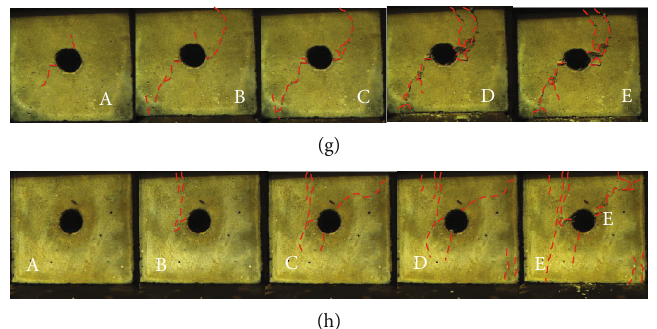
Figure 9: Comparison of crack growth of specimens when the lateral pressure is 0MPa. (a) Details of SN0-1 stress-strain curve. (b) Details of SN0-2 stress-strain curve. (c) Details of SN0-3 stress-strain curve. (d) Details of SN0-4 stress-strain curve. (e) SN0-1 crack growth process. (f) SN0-2 crack growth process. (g) SN0-3 crack growth process. (h) SN0-4 crack growth